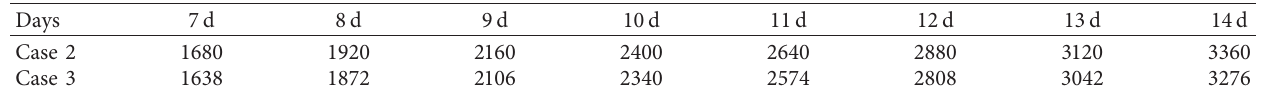
Table 5: The maturity data in Case 2 and Case 3 ( ° C · h).